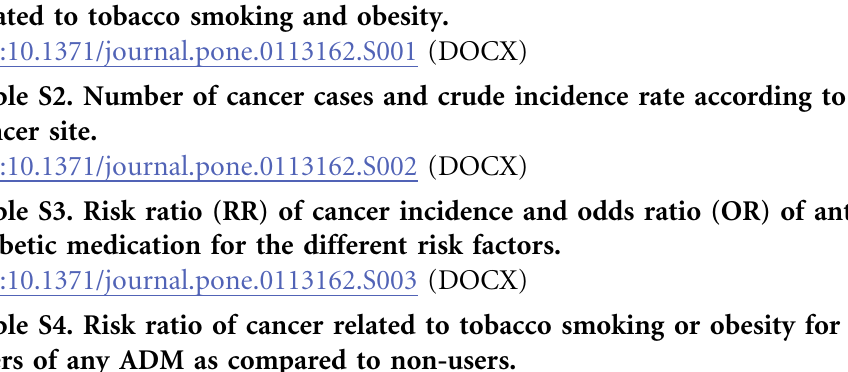
Table S1. Number of cancer cases and crude incidence rate for the cancer sites related to tobacco smoking and obesity. Table S2. Number of cancer cases and crude incidence rate according to the cancer site. Table S3. Risk ratio (RR) of cancer incidence and odds ratio (OR) of anti- diabetic medication for the different risk factors. Table S4. Risk ratio of cancer related to tobacco smoking or obesity for the users of any ADM as compared to